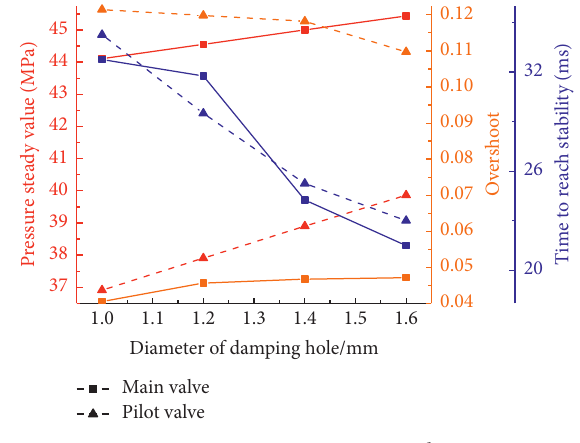
Figure 17: Dynamic response